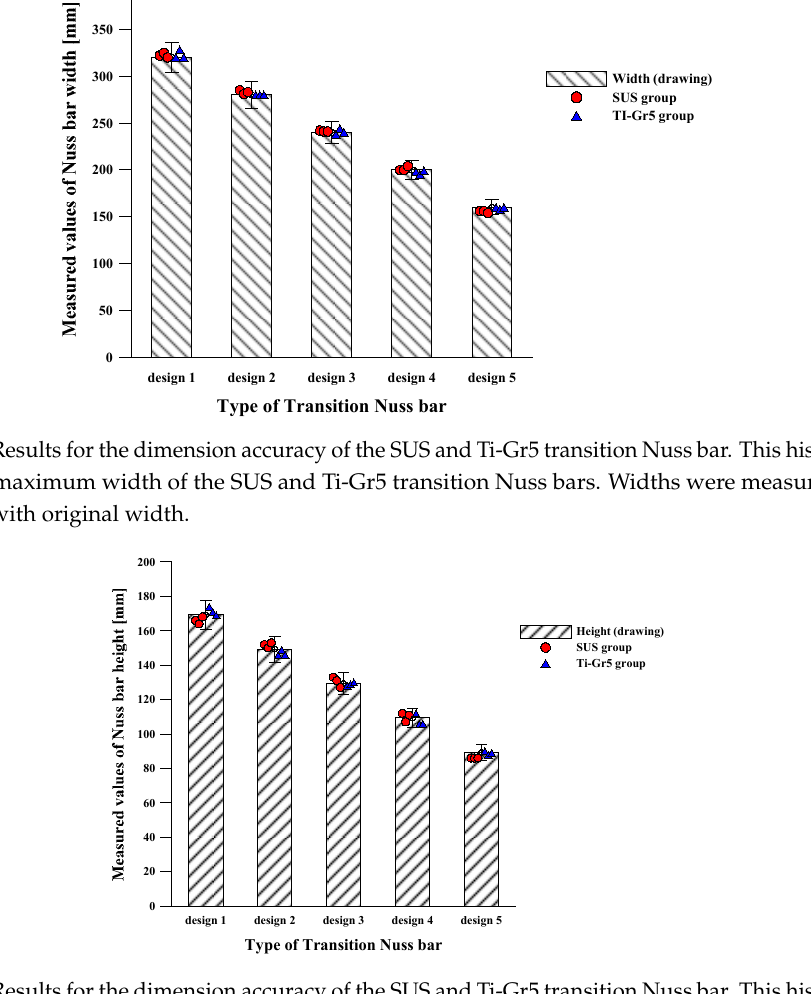
Figure 19. Results for the dimension accuracy of the SUS and Ti-Gr5 transition Nuss bar. This histogram shows the maximum height of the SUS and Ti-Gr5 transition Nuss bars. Heights were measured and compared with original height.